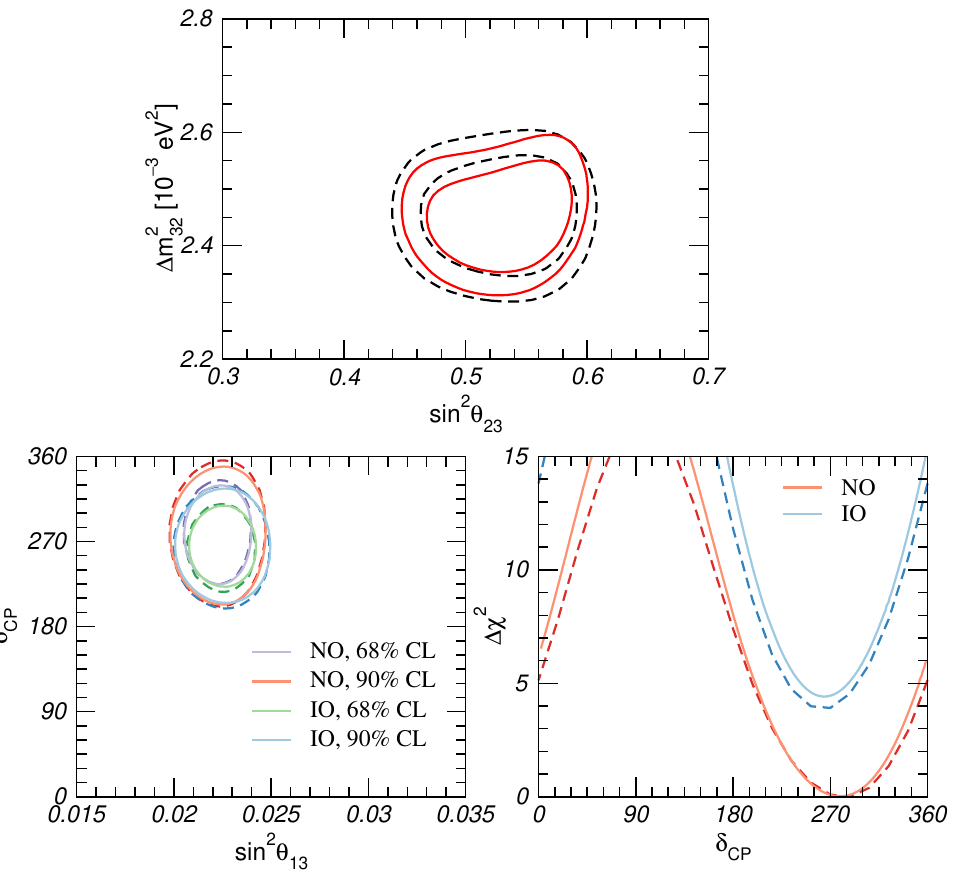
Figure 12 . Di(cid:11)erent projections to our (cid:12)t to latest T2K data (dashed lines) compared to the corresponding results of the experimental collaboration (solid curves), as presented in ref. [73], when adopting the same assumptions. All unshown parameters are marginalised